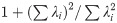
Learning the feedback signal is possible for within- but not for outside-manifold perturbations.(A) Regression is used to learn feedback weights. (B-C) Result of feedback learning for a within-manifold perturbation (WMP) (B) and an outside-manifold perturbation (OMP) (C). Accuracy of predicting neural dynamics from cursor dynamics is measured by R2. Similarity between inferred and correct feedback weights is measured by calculating the correlation coefficient between both. (D) Feedback learning results depend on the number of trials used for regression. Dashed lines show the feedback learning result for taking 50 trials. Compared is feedback learning after the initial training phase (where BCI readout and internal manifold completely overlap) (black), after within-manifold perturbation (red) and after outside-manifold perturbation (blue). (E) Recurrent relearning using the learned feedback weights. As before, task performance is quantified by calculating the mean squared error (MSE) between target cursor velocity and produced cursor velocity. Compared is task performance after within- (WMP) or outside-manifold (OMP) perturbation to performance after relearning with inferred feedback weights (WMR and OMR respectively) (F) Accuracy in the feedback learning, measured by the correlation coefficient between correct and inferred feedback weights, affects recurrent relearning performance, measured by mean squared error. (G) Alignment of internal manifold and readout determines feedback learning performance. To take into account variance in feedback learning for within-manifold perturbations, we calculate the manifold overlap only up to a network-specific dimension, not up to 10 dimensions as done in the rest of the paper. The specific dimension is defined as 1+(∑λi)2/∑λi2 where λi are the Eigenvalues of the covariance matrix. The data points show feedback learning results for 20 simulations, whereas the black lines are interpolations between OMP and initial BCI mappings for which we evaluated feedback learning.